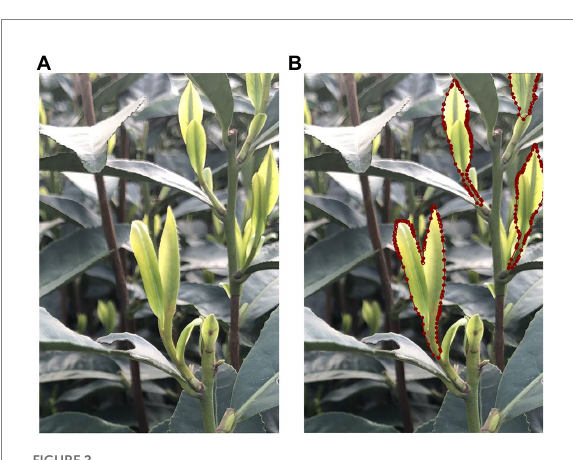
FIGURE 2 Instance segmentation example of tea shoots dataset (A) original image, (B) the visualization of the boundary points for the